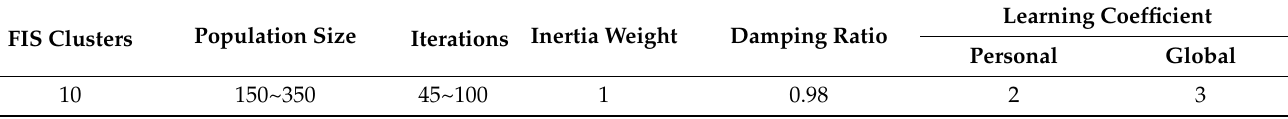
Table 8. The parameter characteristics used for FS are also indicated in Table 8 Table 7. Parameter characteristics used for PSO in this study.